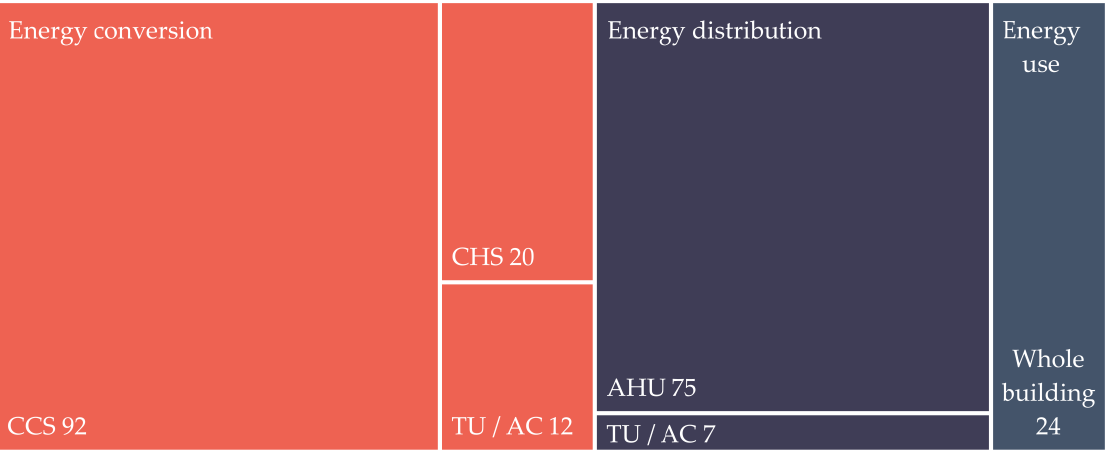
Figure 8. Number of articles within each EST group.